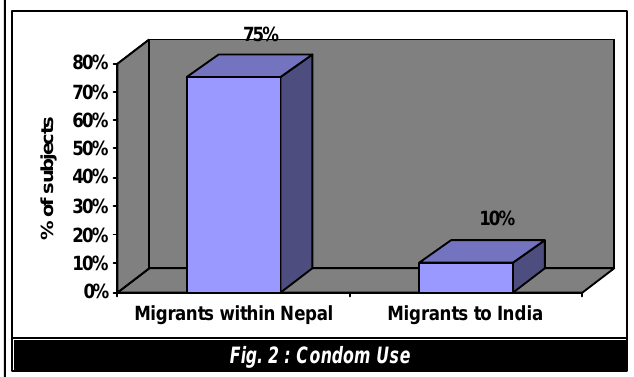
Fig. 2 : Condom Use